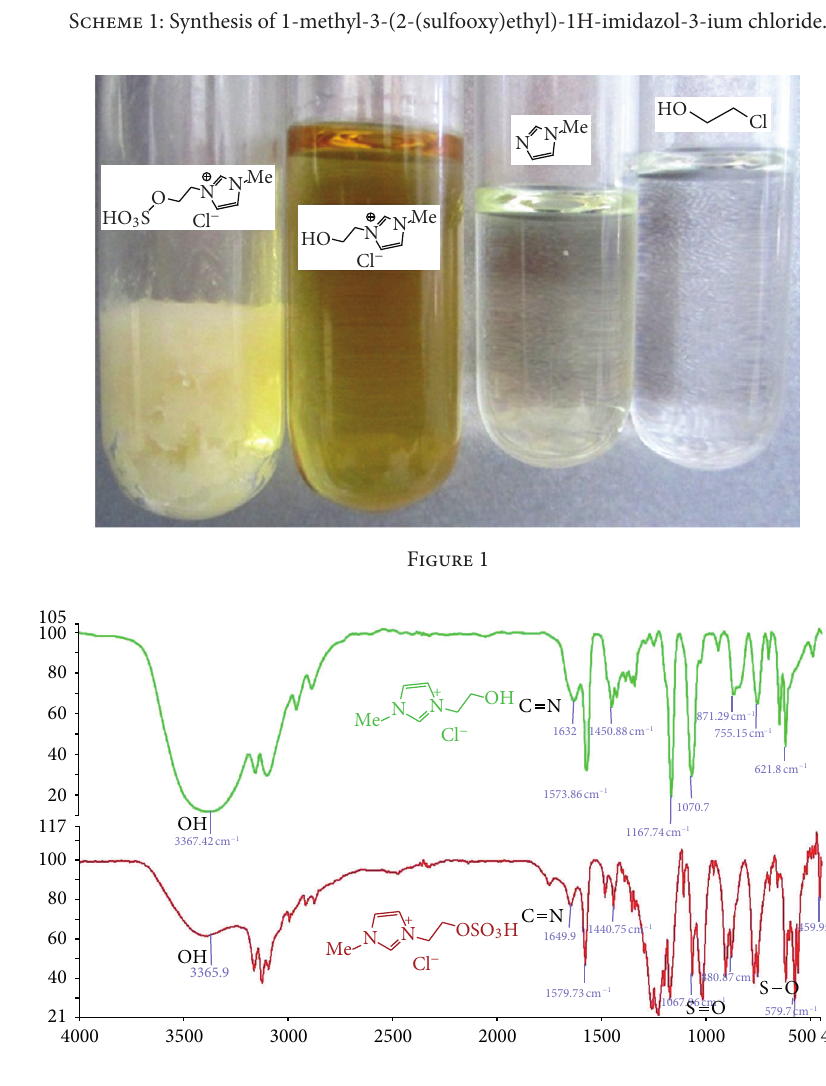
F 2: Comparison IR spectrum of ionic liquid 3 , bronsted acidic ionic liquid